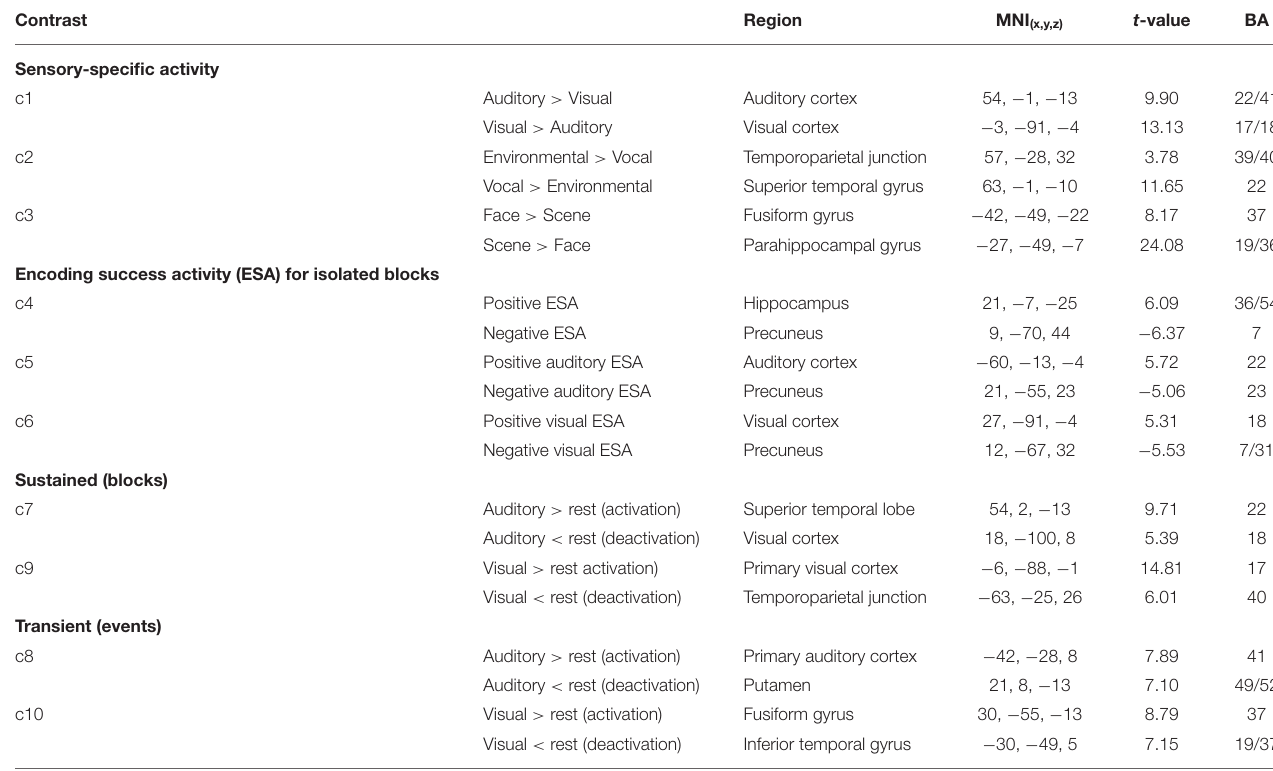
TABLE 2 | Maximally activated and deactivated brain regions for each contrast. Contrast Sensory-specific